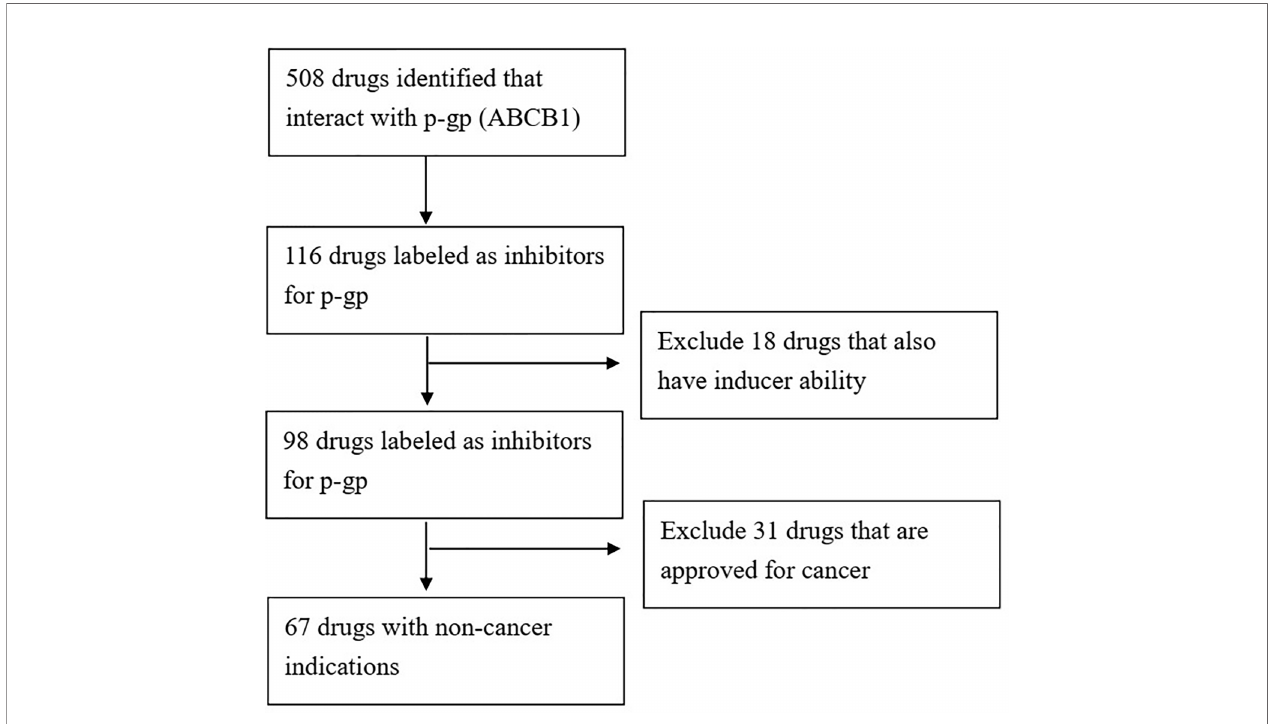
FIGURE 1 | Flowchart of discovery of repurposing FDA approved drugs with p-gp inhibition abilities.